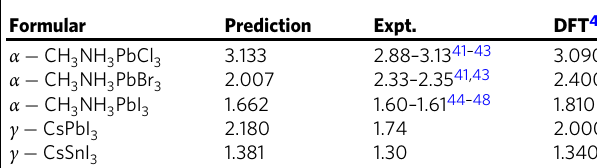
Table 3 Band gap predictions vs. experimental results vs. DFT calculations (eV). α ; γ denotes cubic system and orthorhombic system, respectively.